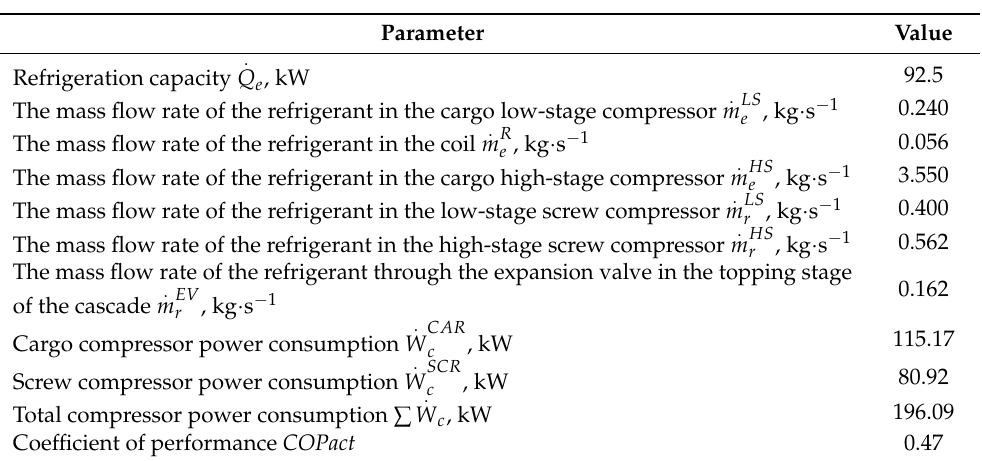
Table 2. System simulation results.